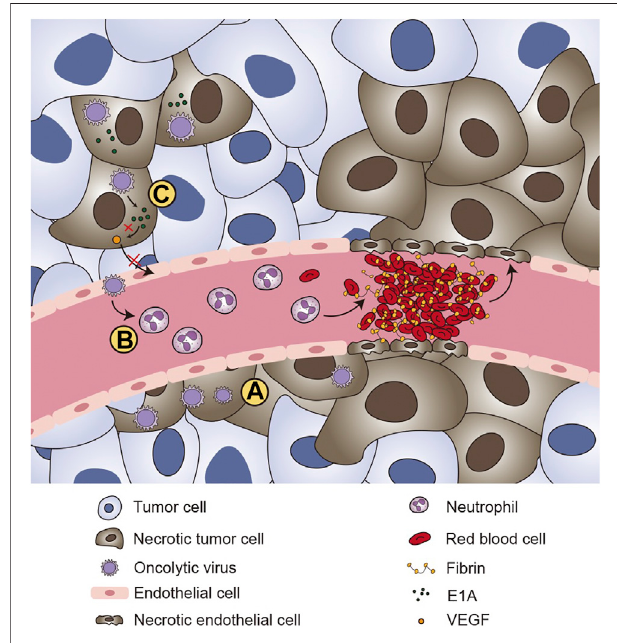
FIGURE 1 | The effects of tumor lysis of oncolytic virus. (A) Oncolytic virusesareabletokilltumorcellsdirectly. (B) Afterinfectingtheendotheliumof the tumor vasculature, oncolytic viruses are able to recruit neutrophilcells and mediate the formation of clots and vascular collapse, which induce the ischemic death of tumor cells. (C) VEGF plays an important role in the regulationofangiogenesisandtumorgrowth.Somespeci fi concolyticviruses, such as adenovirus, can express the E1A protein, which can downregulate VEGF by interacting with angiogenic proteins, thereby affecting new blood vessels in the tumor microenvironment and ultimately achieving oncolytic